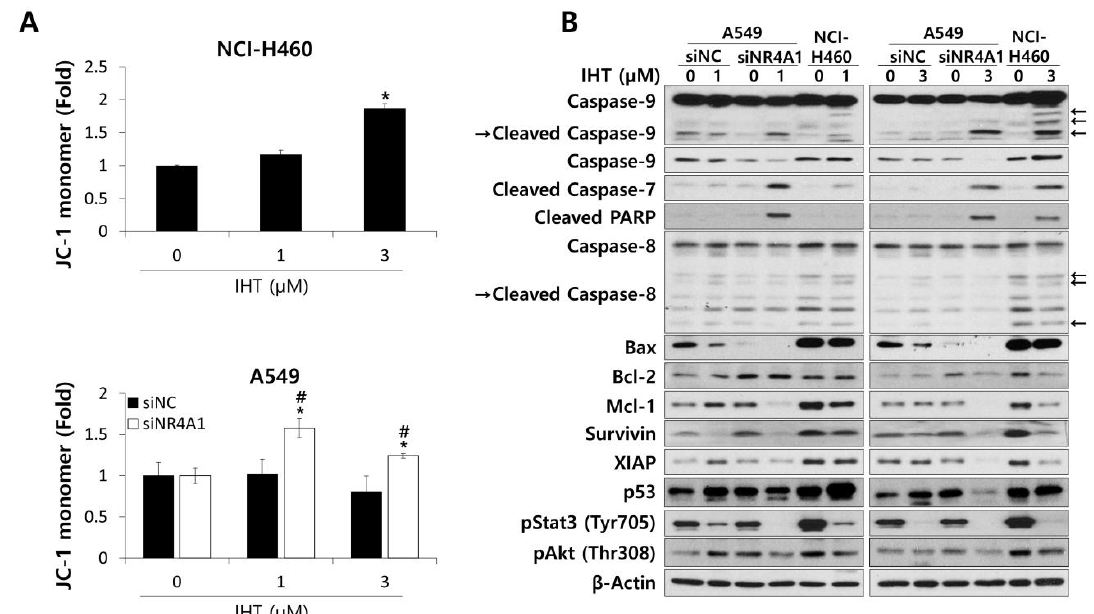
Figure 5. IHT induced mitochondria-mediated apoptosis in 3D-cultured NCI-H460 cells and A549 cells treated with siNR4A1. ( A ) To detect alteration of mitochondria membrane potential, tumorspheroids were dissociated into single cells after IHT treatment for 48 h. Cells were stained with tetraethylbenzimidazolylcarbocyanine iodide (JC-1) and analyzed by flow cytometry. *, significantly different from siNR4A1 control ( p < 0.05); #, significantly different from siNC control ( p < 0.01). All data are presented as mean ± SD. ( B ) Whole cell lysates were prepared from NCI-H460 and siRNA-transfected A549 tumorspheroids 48 h after IHT treatment. The levels of apoptosis-related proteins were analyzed by western blotting. β-Actin was used as a loading control.